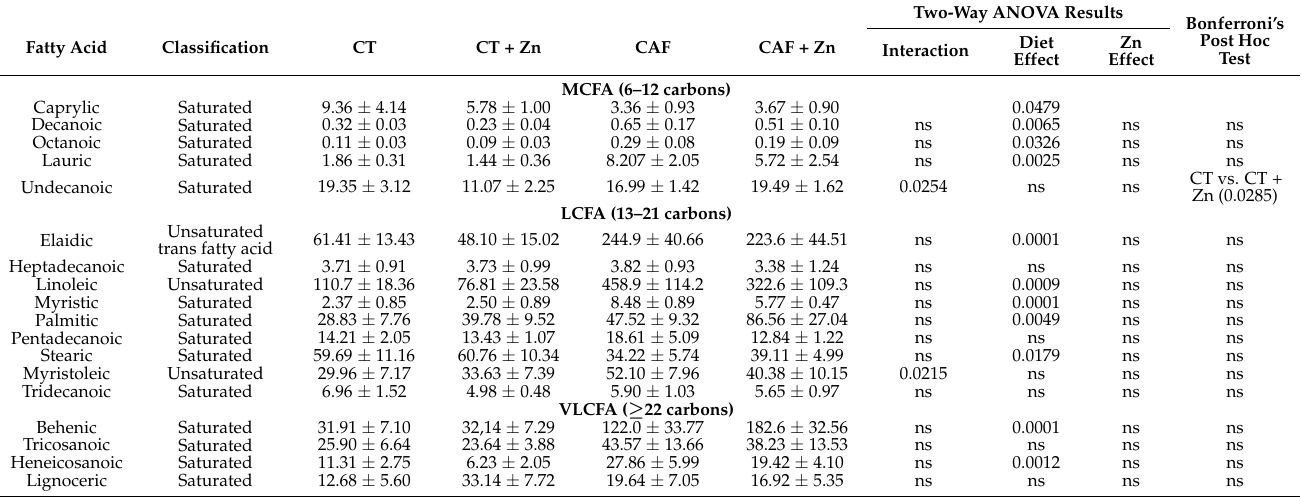
Table 1. Medium-chain fatty acid (MCFA), long-chain fatty acid (LCFA) and very long-chain fatty acid (VLCFA) concentrations in the proximal portion of the colon ( µ